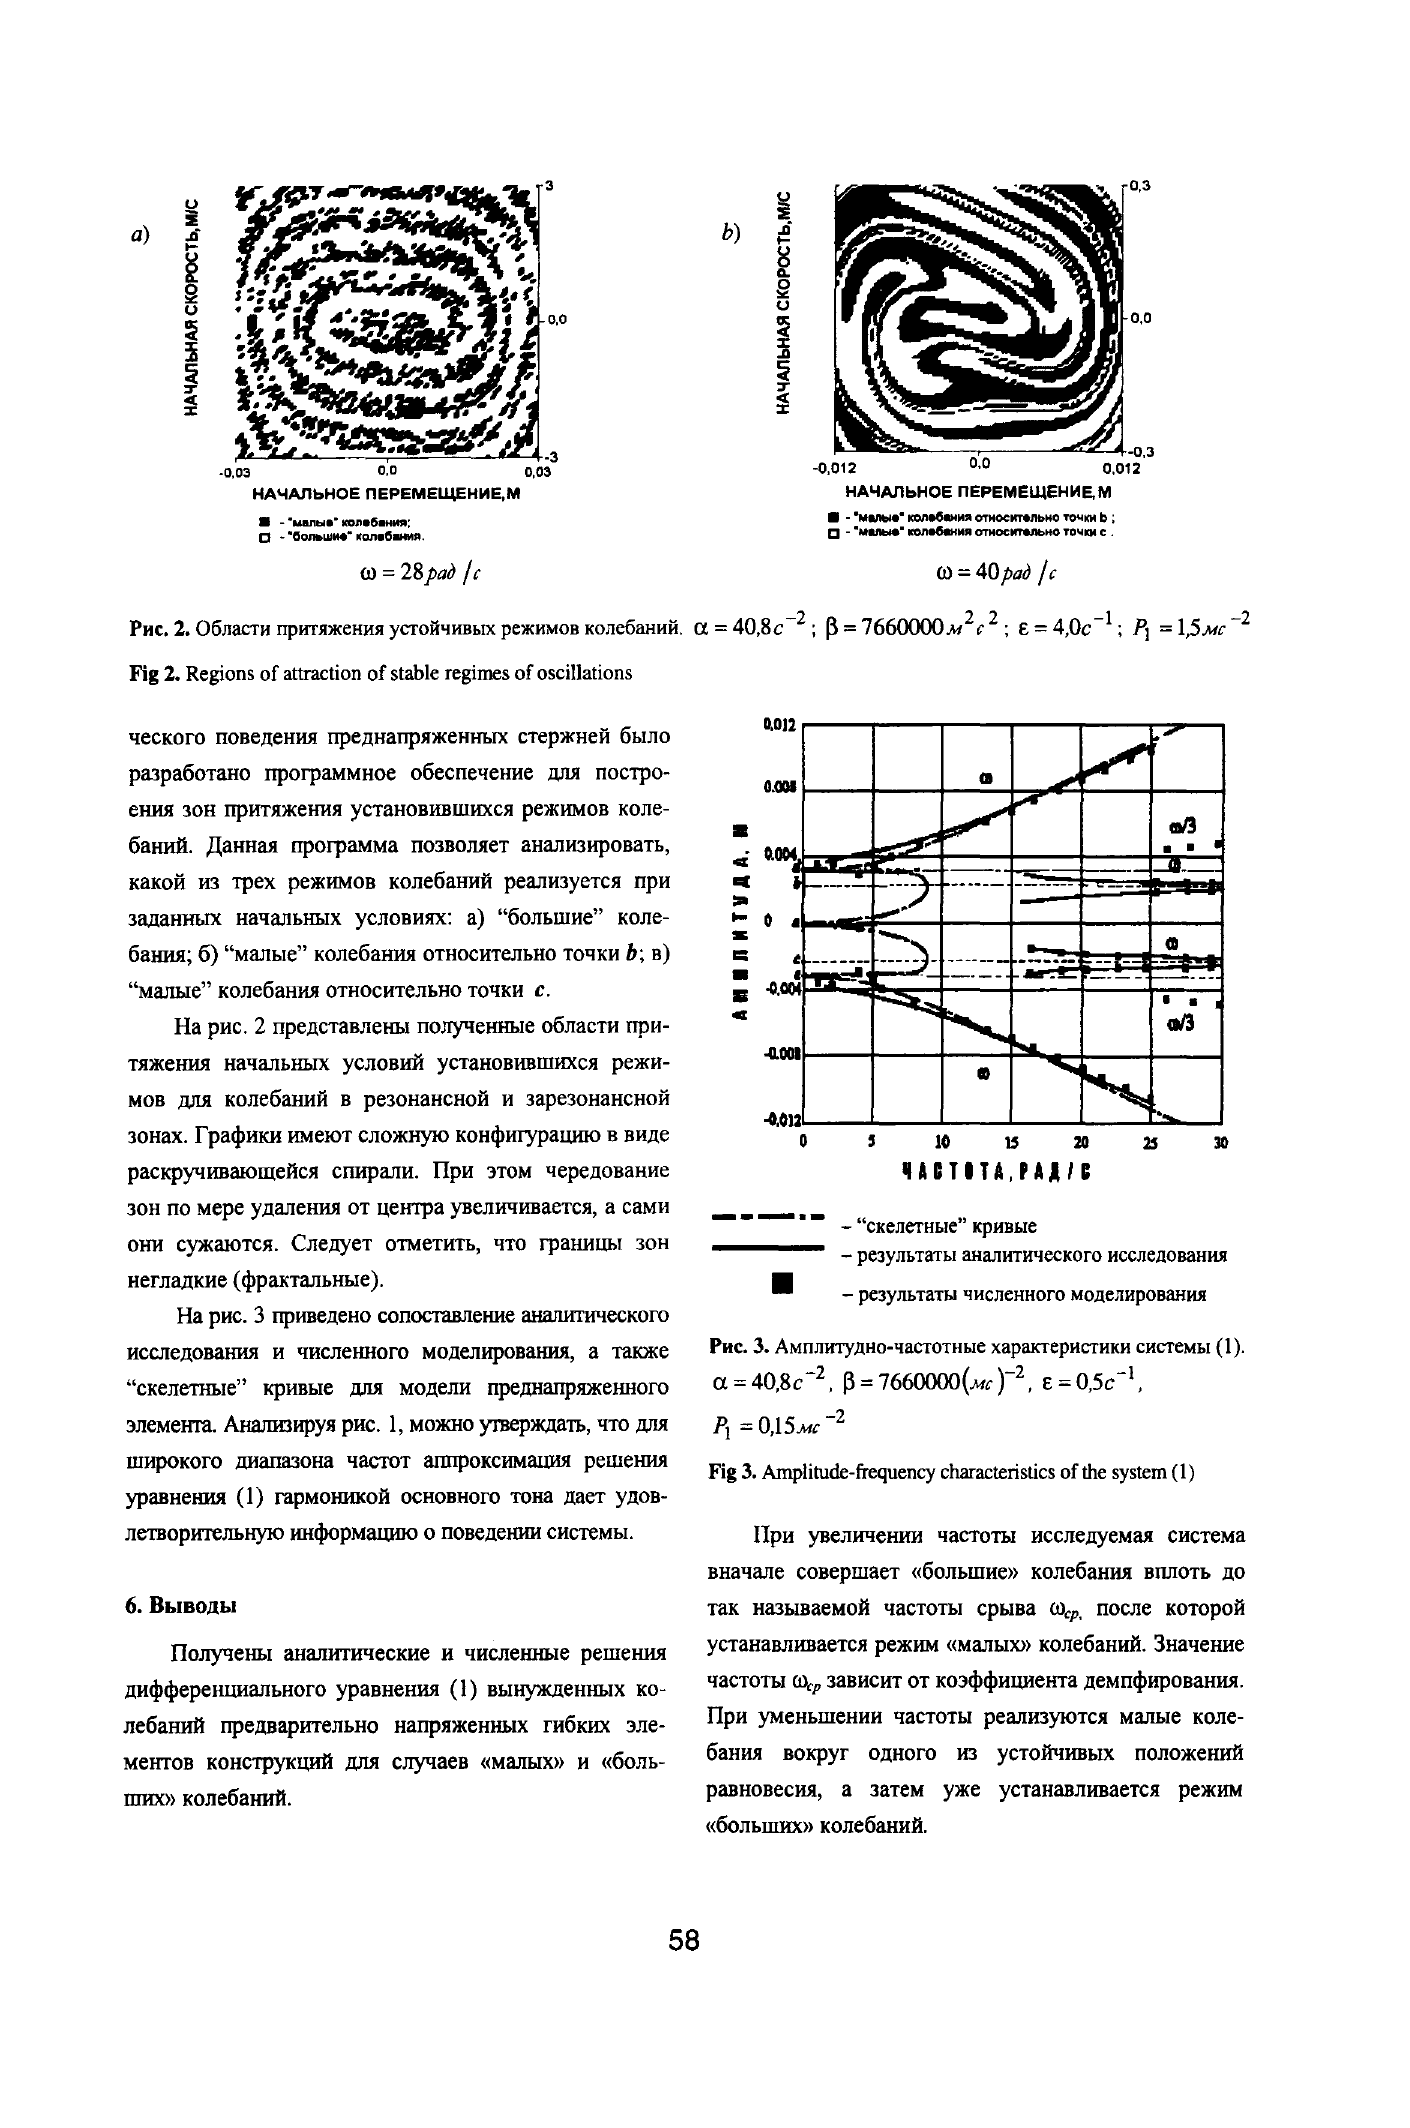
Fig 3. Amplitude-frequency characteristics of the system